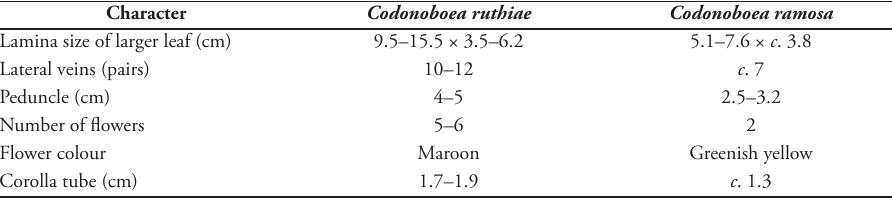
Table 1. Differences between Codonoboea ruthiae and C. ramosa